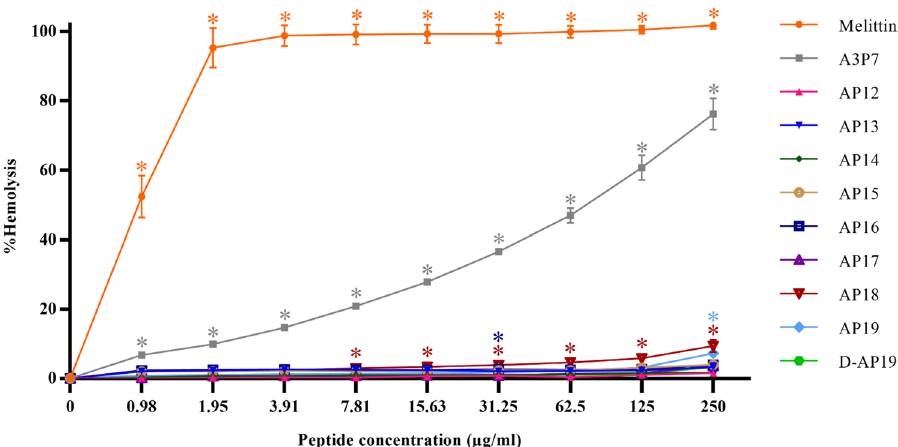
Figure 1. The hemolytic activity of parent peptide, A3P7, and its derivatives compared with that of melittin (a positive control). Three independent experiments were performed and the data are presented as mean ± SD. The statistical analyses utilized one-way ANOVA and Tukey’s test (GraphPad Prism7). Star indicates a significant difference from negative control (* p -value < 0.05).